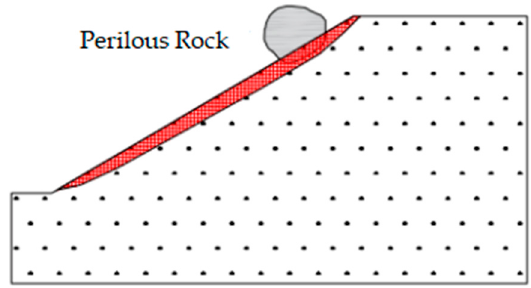
Figure 1. Schematic diagram of perilous rock on a soil slope.